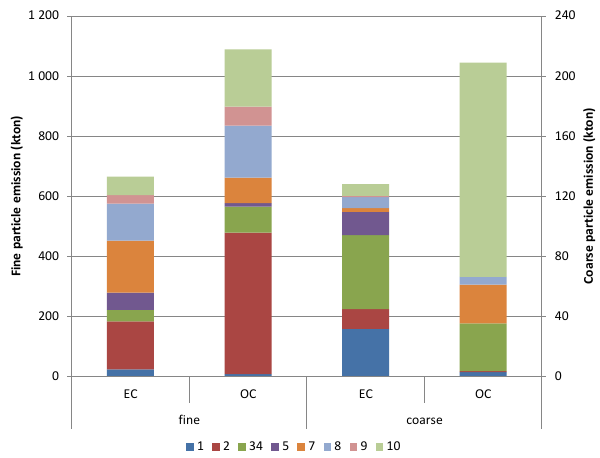
Figure 6. Total EC and OC emissions per SNAP in coarse (2.5– 10µm) and fine mode (<2.5µm) for UNECE-Europe (including sea regions) for the year 2005. Note that fine EC and OC are plotted on the left y -axis, while coarse EC and OC are plotted on the right y